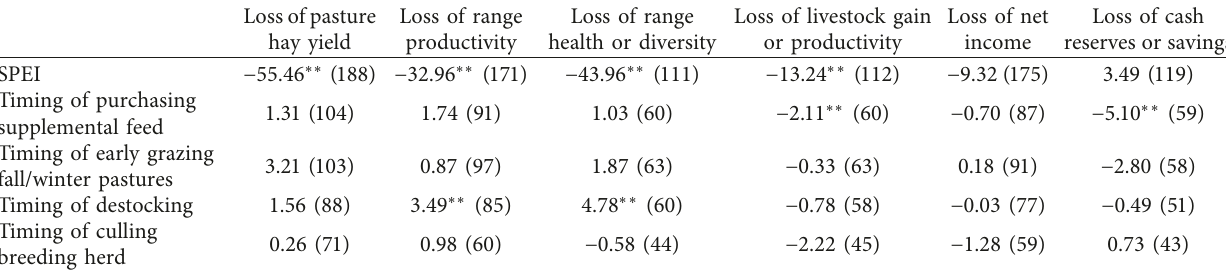
Table 4: Factors affecting drought impacts.